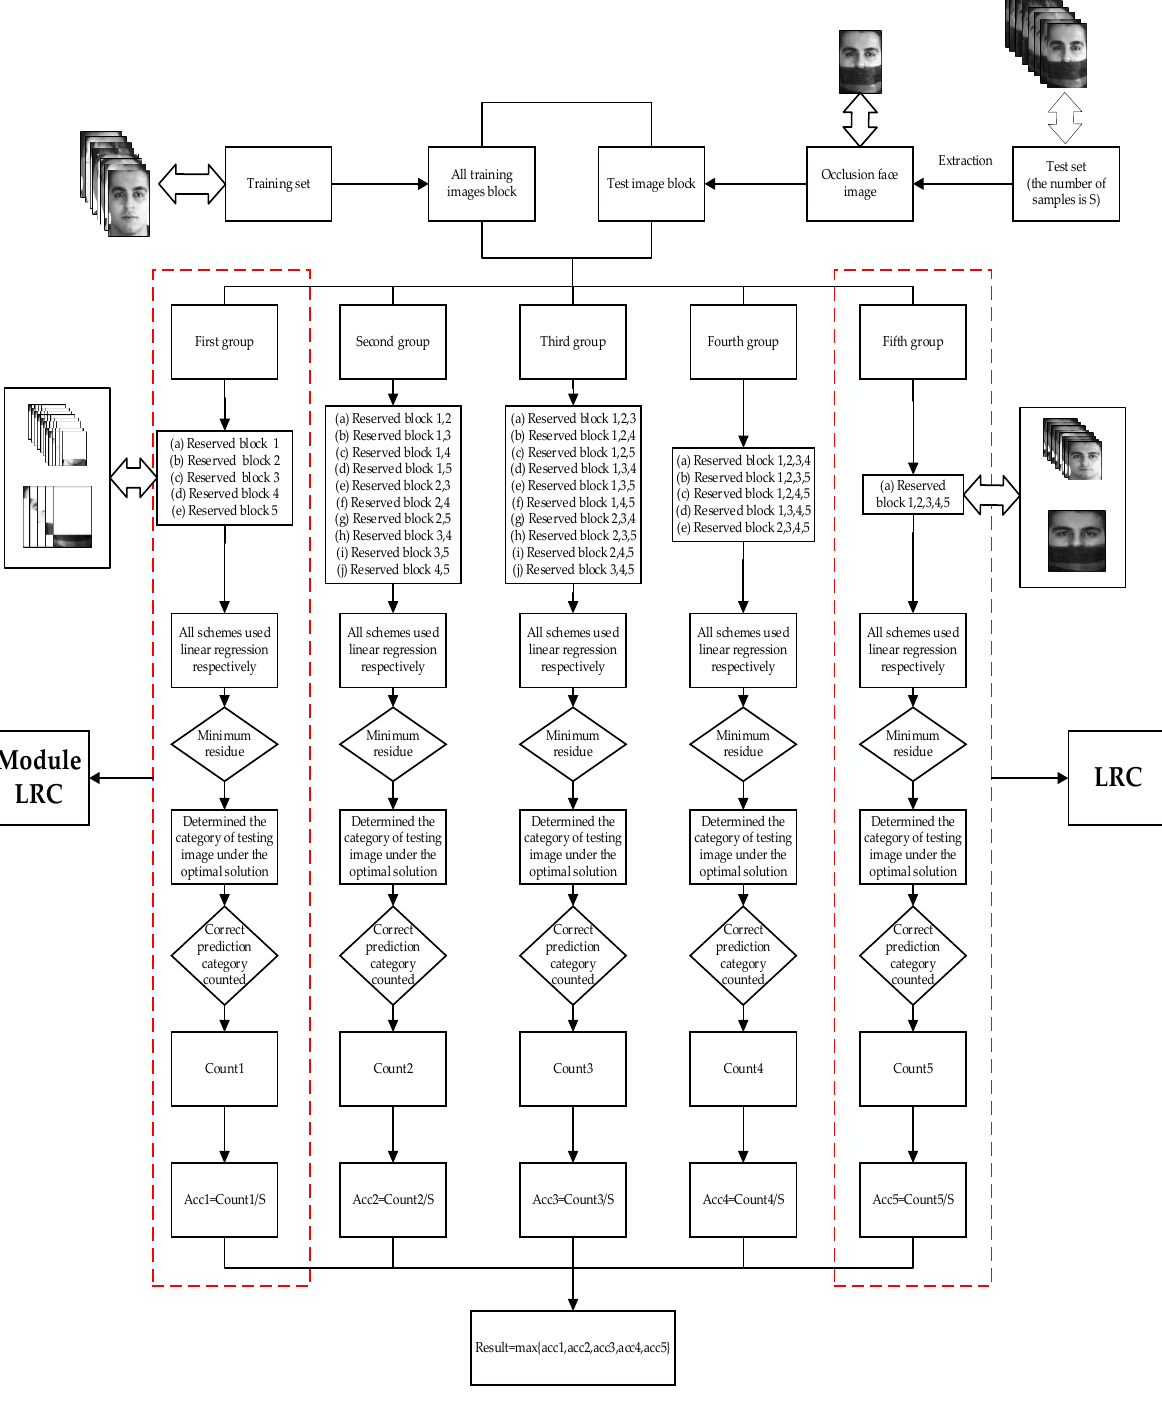
Figure 1. The overall workflow of the BPLRC method (with 5 blocks) [ Reprinted with permission from Elsevier [20]. Copyright 2013, Neurocomputing ] .